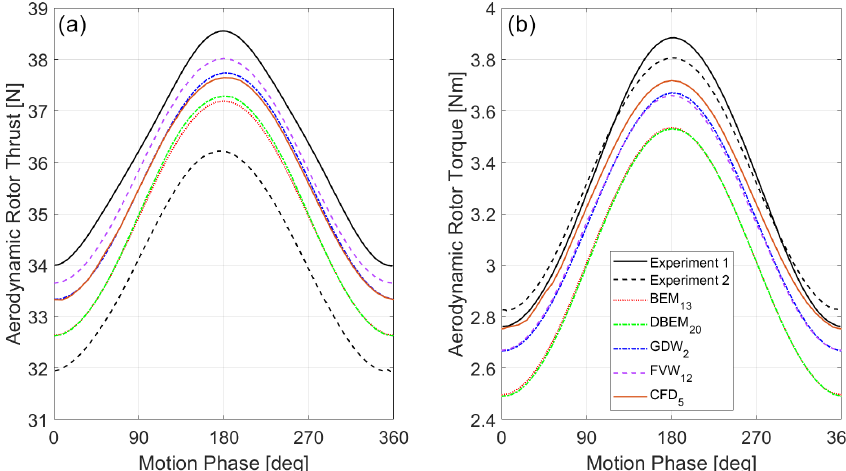
Figure 16. Aerodynamic rotor thrust (a) and torque (b) during the unsteady wind condition in Load Case 2.5.